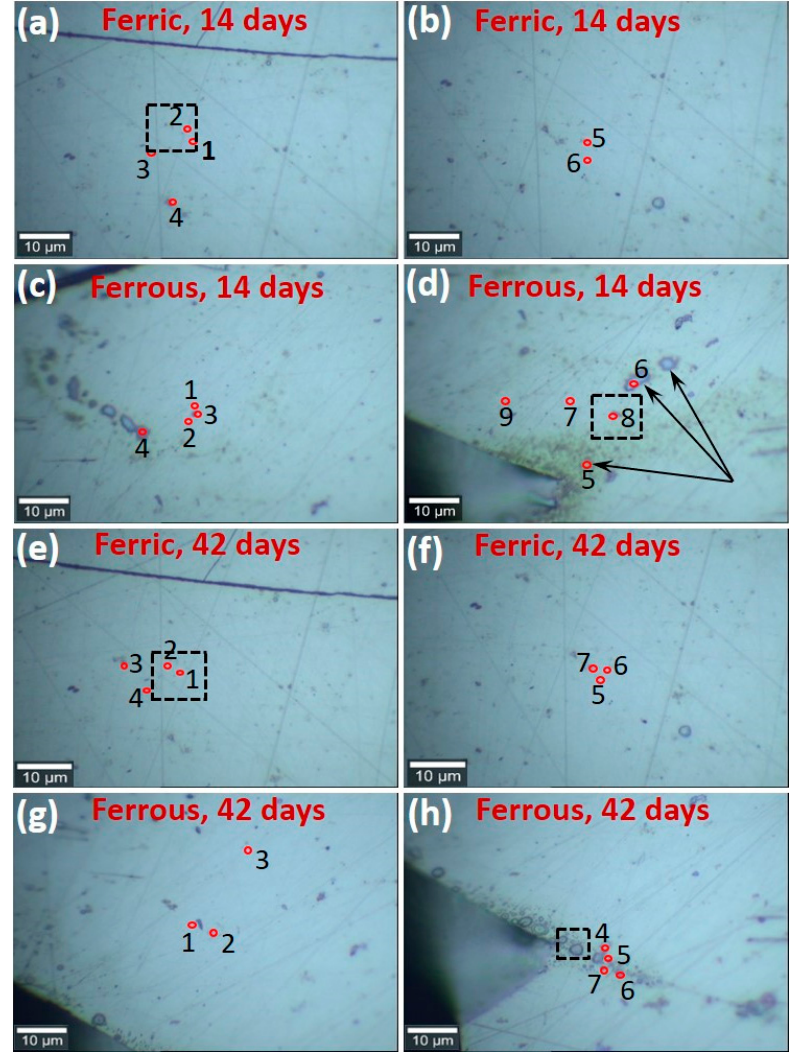
Figure 2. Optical images showing the positions of Raman spot analyses for chalcopyrite samples leached with ferric and ferrous for 14 ( a – d ) and 42 days ( e – h ). Rectangular areas indicate imaging